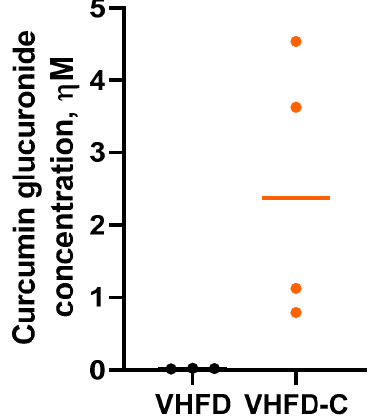
Figure 2. Curcumin glucuronide (CG) bioavailability in mouse serum. Serum was obtained from blood, collected by cardiac puncture during euthanization. CG concentration was determined by liquid chromatography mass spectrometry (LC-MS/MS). n = 3–4.